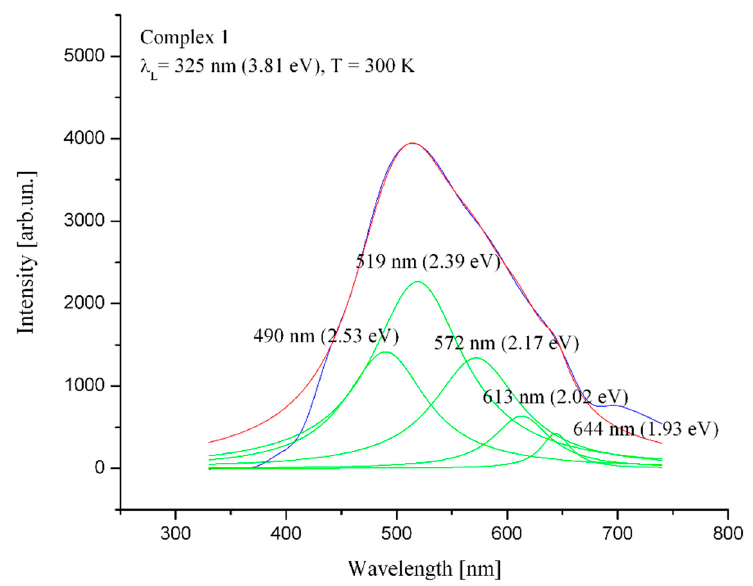
Figure 6. Photoluminescence characteristics of Complex 1 . Blue, curve of the experimental intensity; red, curve of the fitted total intensity; green, curve of the fitted individual peaks.